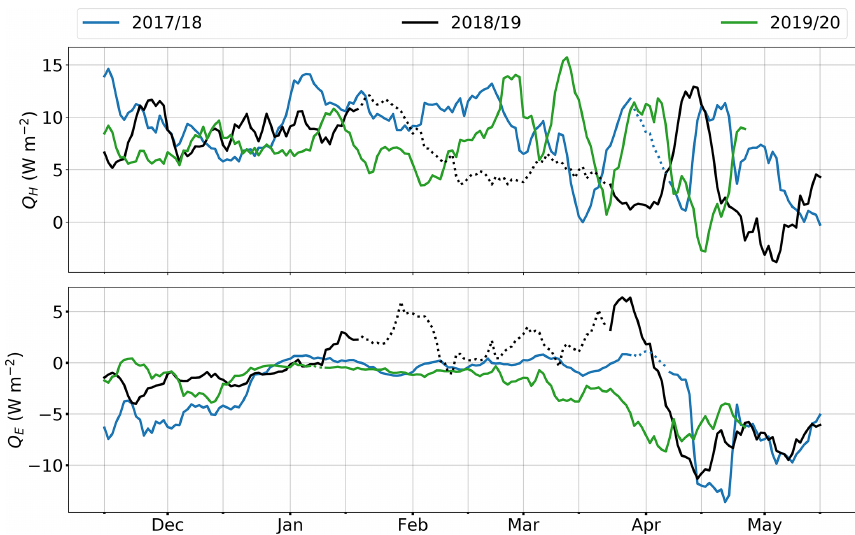
Figure 4. Rolling mean of measured daily sensible heat flux ( Q H ) and latent heat flux ( Q E ) for the study period. Dotted lines indicate periods of instrument failure which have been gap-filled.